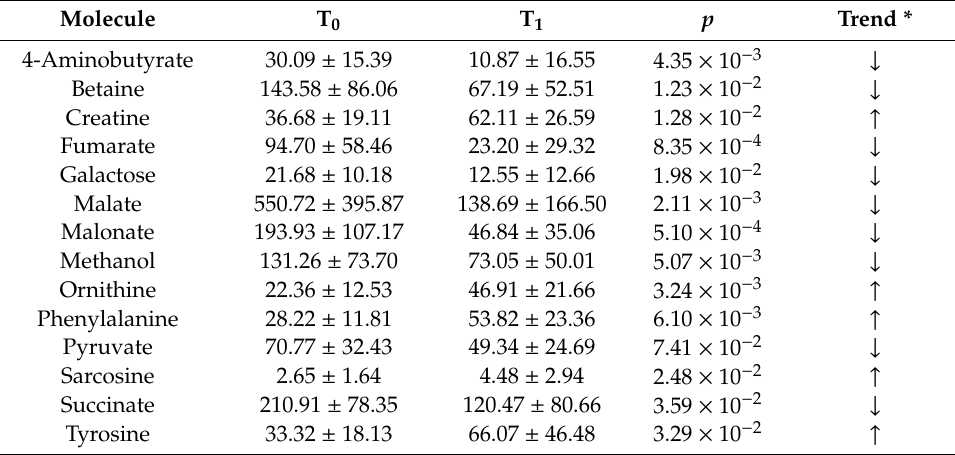
Table 2. Salivary metabolites with di ff erent concentrations ( µ mol / L; mean ± SD) before (T 0 ) and after (T 1 )